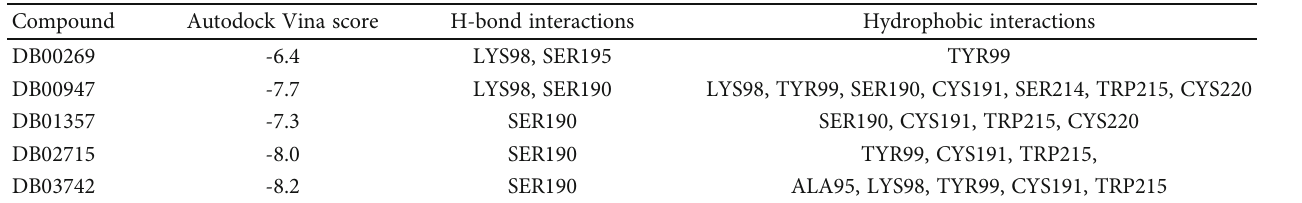
Table 2: Molecular docking of drugs to F9 protein.